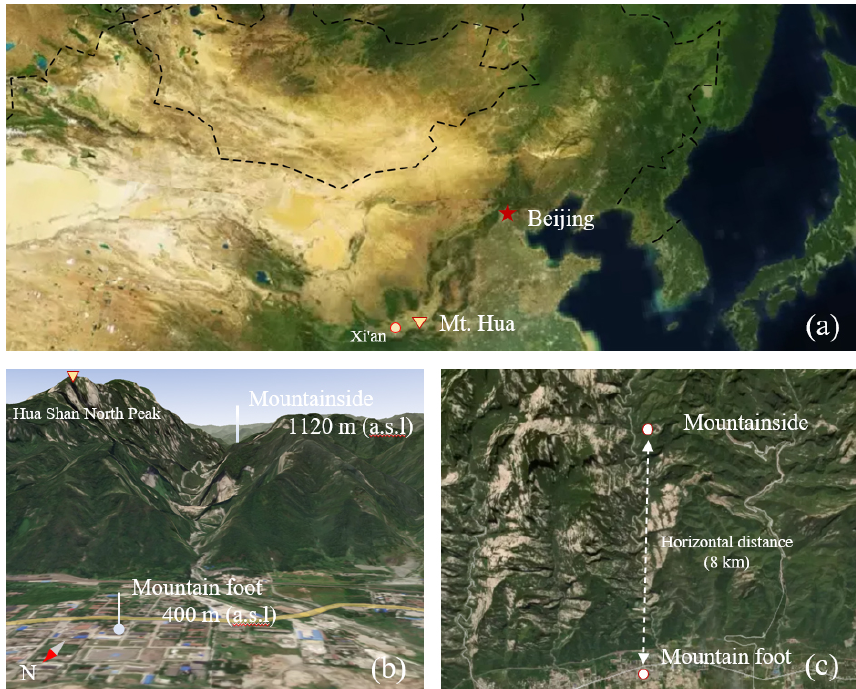
Figure 1. (a) Location of the study sites in China, (b) topographic view of Mt. Hua, with the sampling sites marked, and (c) vertical views of the two sampling sites and the horizontal distance between them. The maps are the reproductions from ©Mapbox (https://account.mapbox. com/, last access: 31 December 2021), with added marks for our study